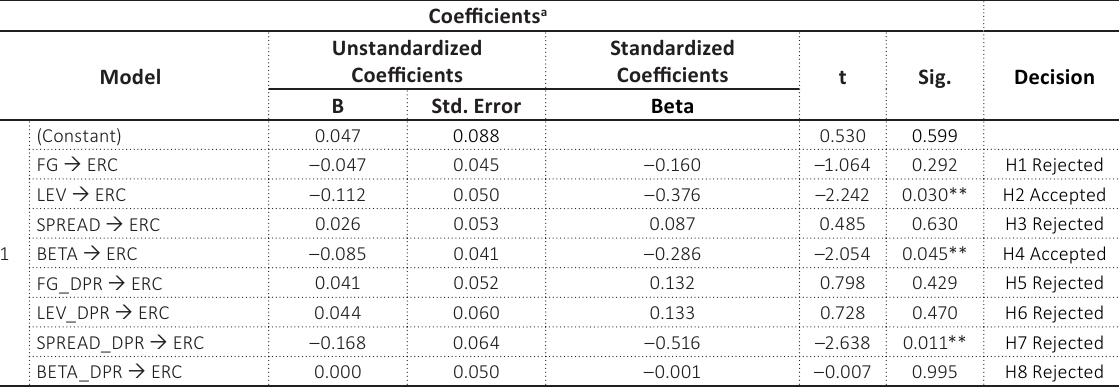
Table 1. Partial significance test results